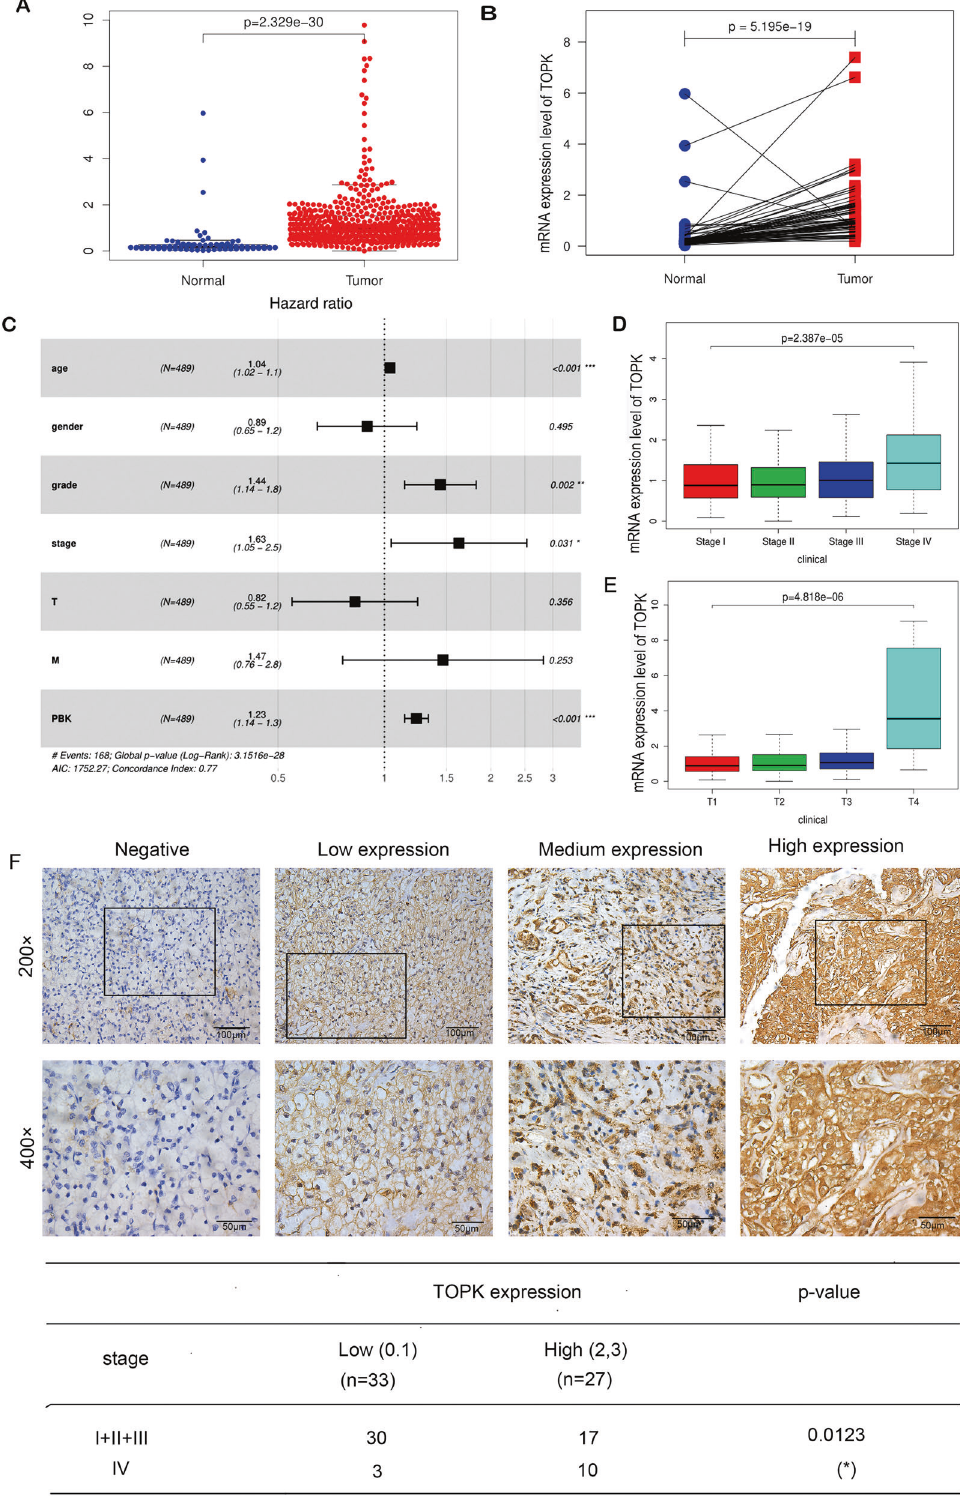
Fig. 1 PBK/TOPK is highly expressed in RCC, especially in advanced RCC. Differential expression analysis of PBK/TOPK on RCC datasets of TCGA, the analysis was performed by R project. A Differential expression analysis of TOPK between RCC and normal kidney tissue. B The paired differential gene expression between normal and RCC tumor tissue. C The forest plot of PBK/TOPK expression impact on kidney cancer was analyzed. D , E The correlation between the expression of PBK/TOPK and classi fi cation or stage of RCC was analyzed. F The expression of PBK/TOPK in tissues of RCC was determined by IHC. Representative views of IHC staining of PBK/TOPK in patients with different grades of RCC were presented (×400 down; ×200 up), Scale bar, 100 μ m or 50 μ m. The correlation between the expression of PBK/TOPK and classi fi cation and stage of RCC was analyzed.